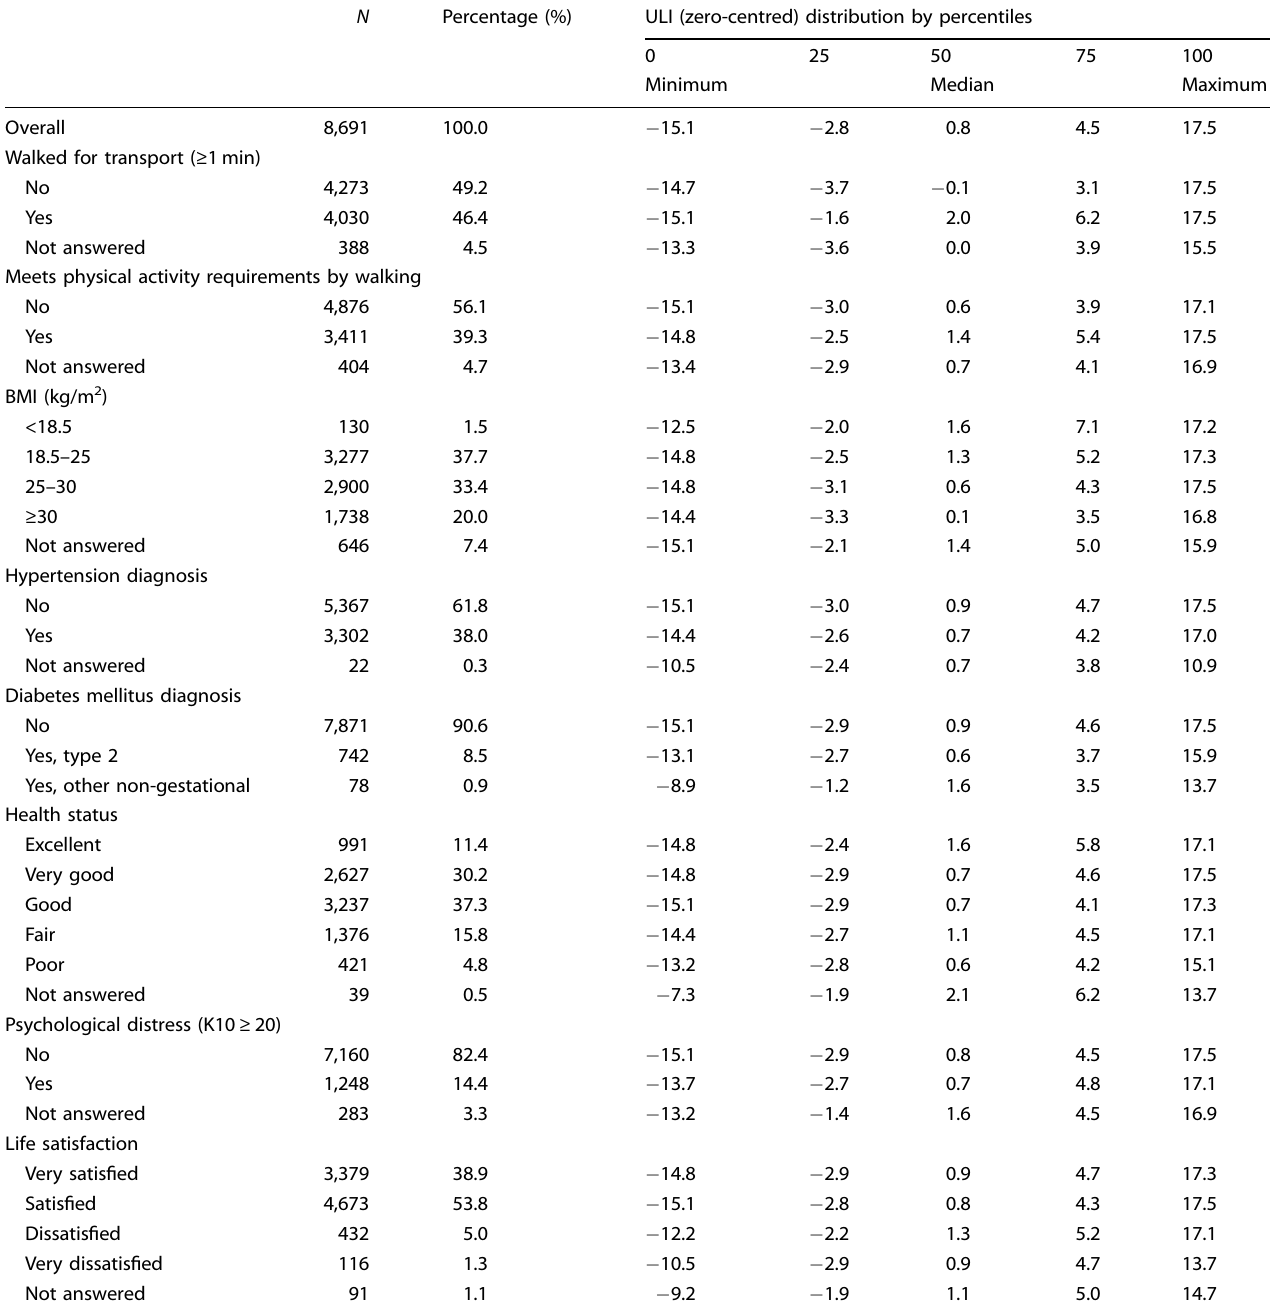
Table 2. Liveability distribution by VPHS participant cardiometabolic risk factor